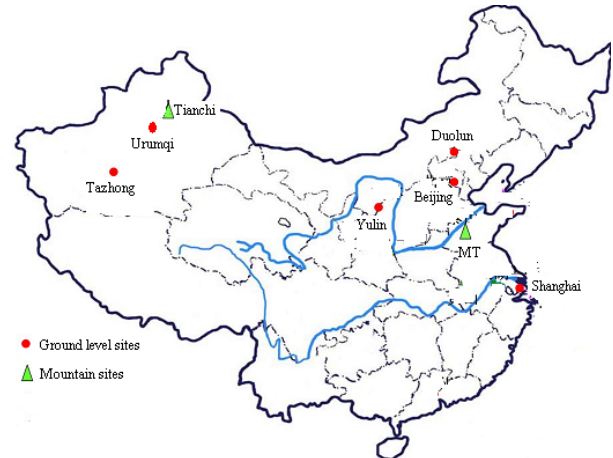
Fig. 1. Map of the sampling sites in this study.